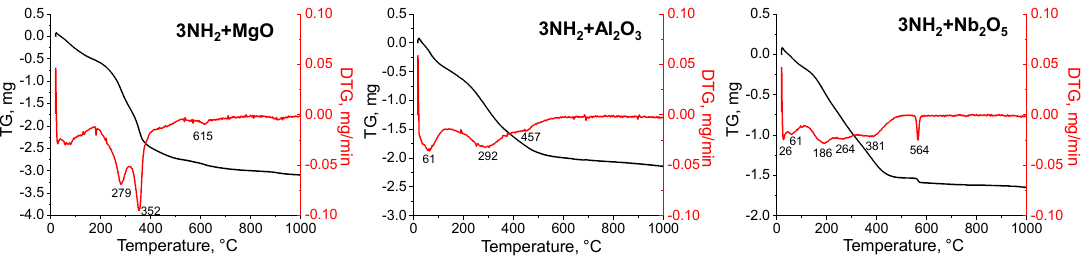
Figure 8. Thermogravimetry analysis of samples modified directly with TAEA.